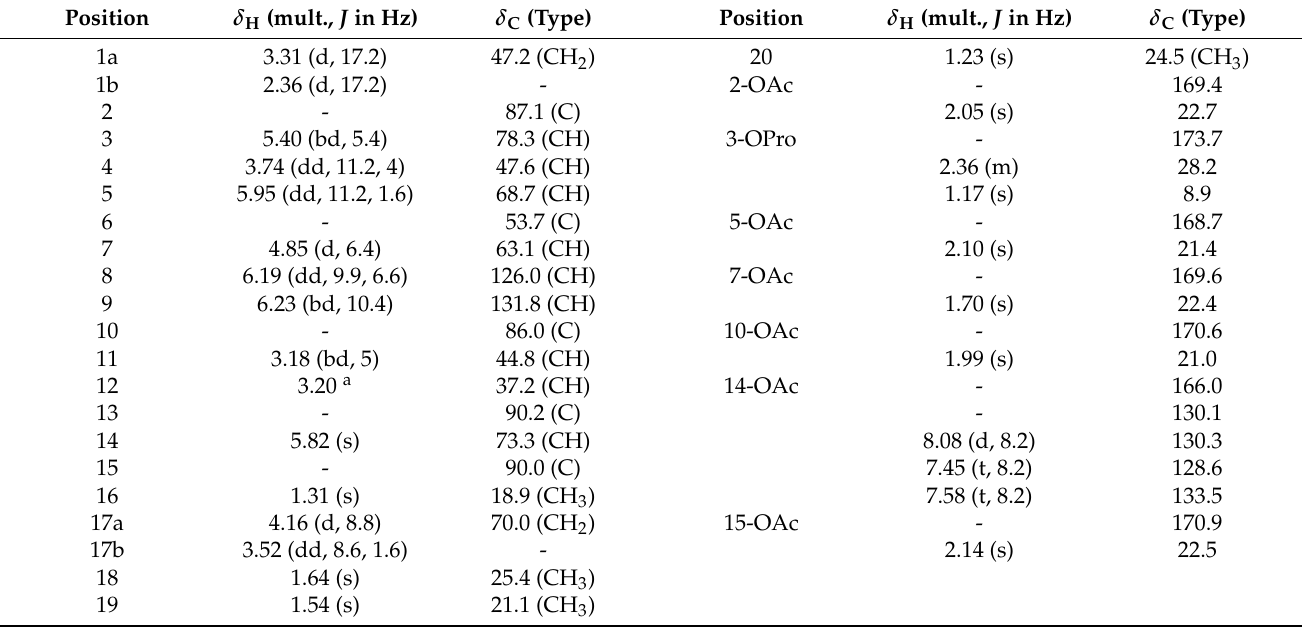
Table 2. 1 H (400 MHz) and 13 C (100 MHz) NMR data of compound 5 in CDCl 3 .